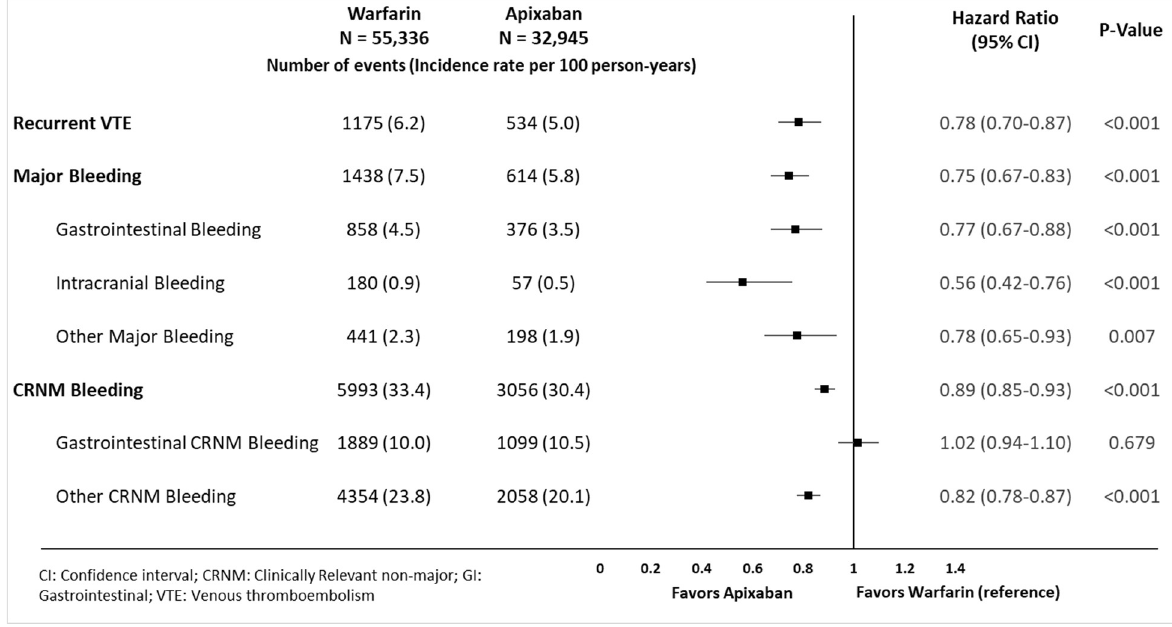
Fig 2. Risk of recurrent VTE, major bleeding, and CRNM bleeding for apixaban vs. warfarin among VTE patients at a high risk of